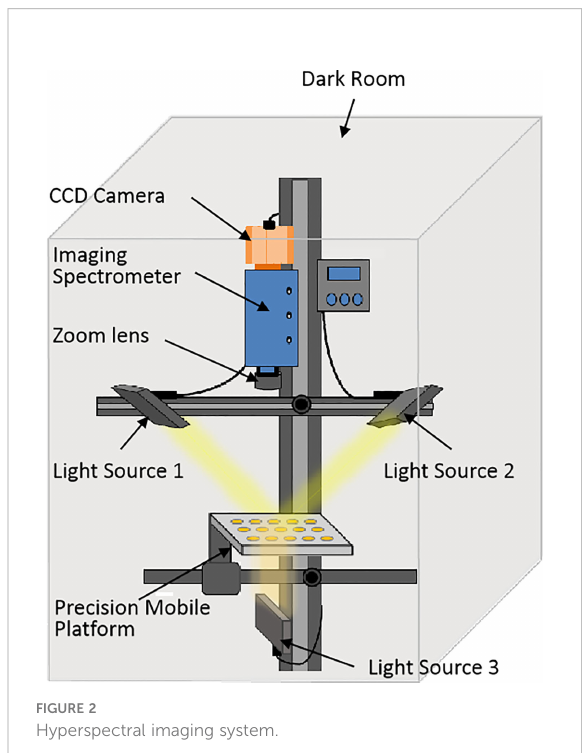
FIGURE 2 Hyperspectral imaging